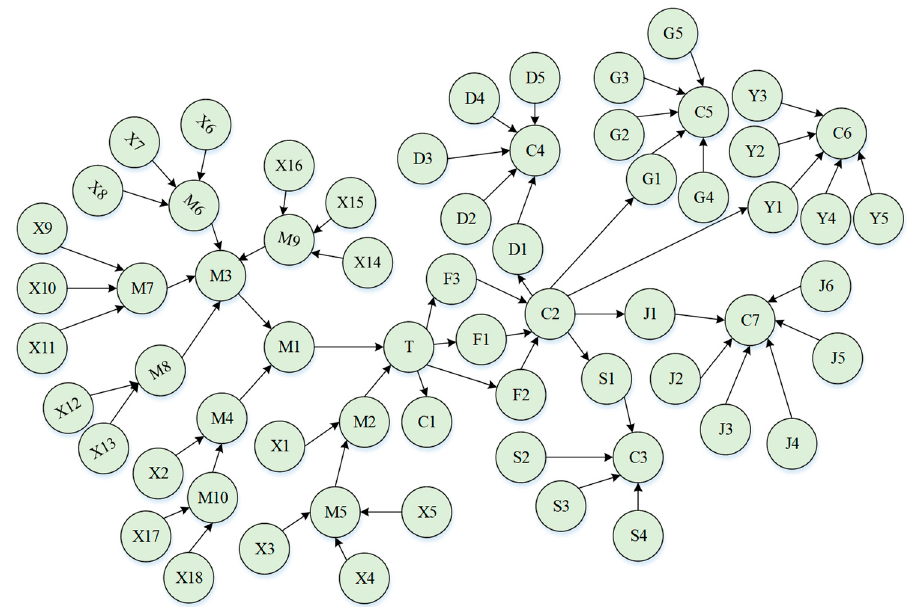
Figure 7. Bayesian network diagram of liquid ammonia leakage.